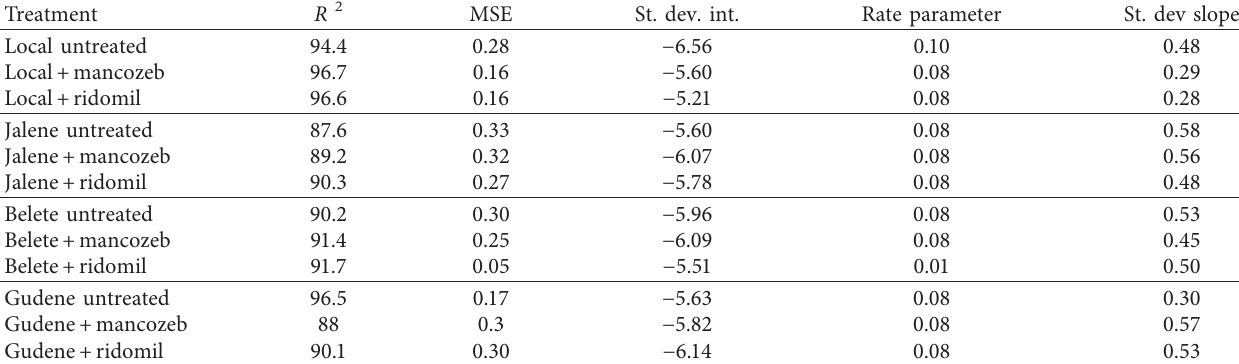
Table 3: Linear regression statistics’ used evaluation of linear logistic growth